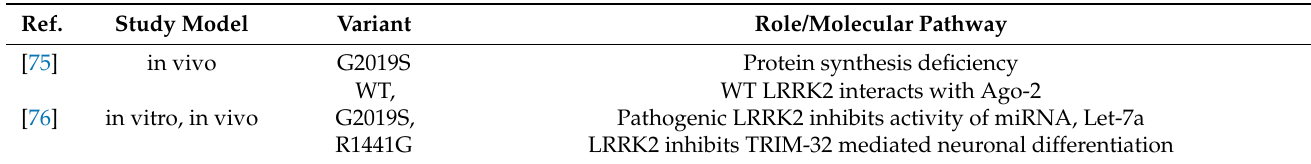
Table 10. Defects in protein synthesis/translation associated with LRRK2.